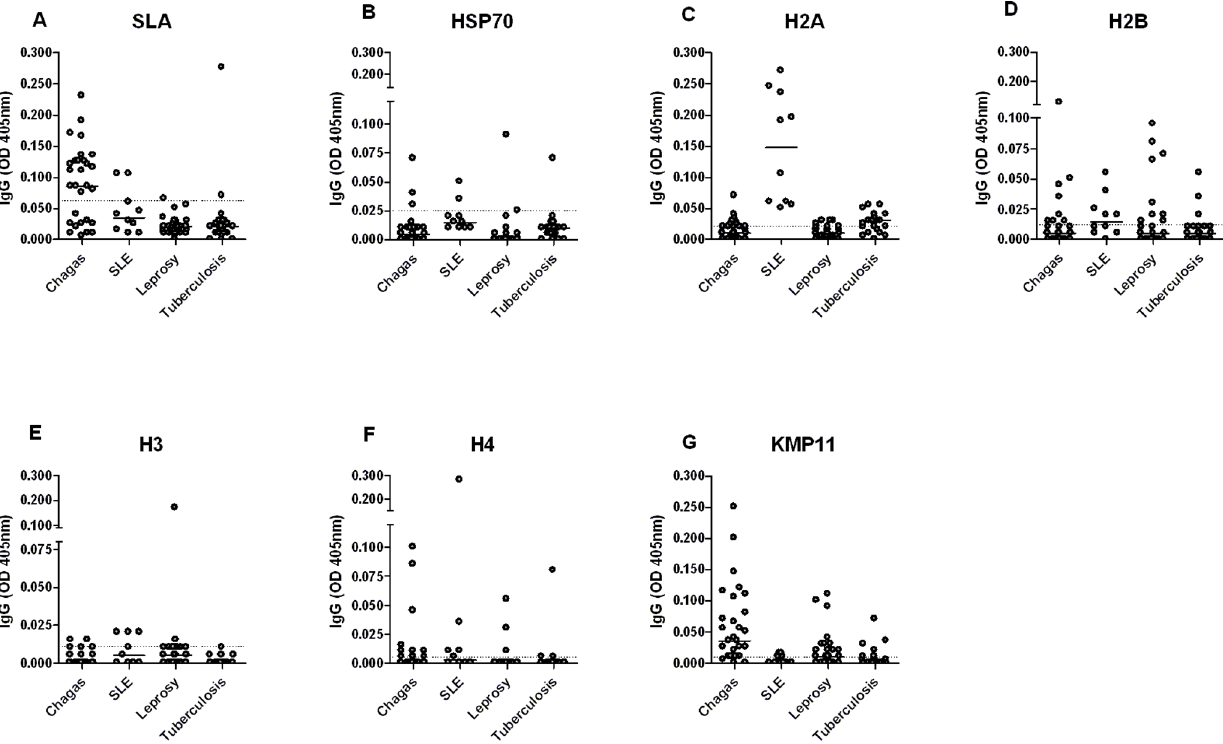
Figure 3. Specificity of ELISA employing parasite antigens. Sera from patients with Chagas’ disease (n=30), SLE (n=10), leprosy (n=30) and tuberculosis (n=22) were tested against SLA (A), rHSP70 (B), rH2A (C), rH2B (D), rH3 (E) rH4 (F) and rKMP11 antigens (G). The cut-off was established from the TL ROC curve (Fig. 2) (dotted line). The solid lines represent median values. Each point represents the mean of duplicate values with a standard deviation lower than 20%.